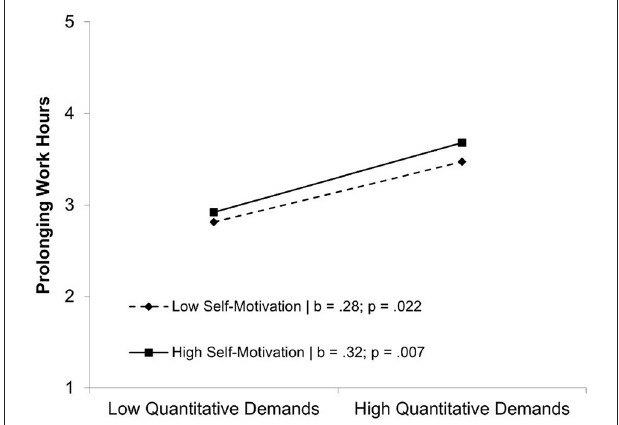
FIGURE 3 | Moderating effect of self-motivation on the relationship between quantitative demands and prolonging of working hours.